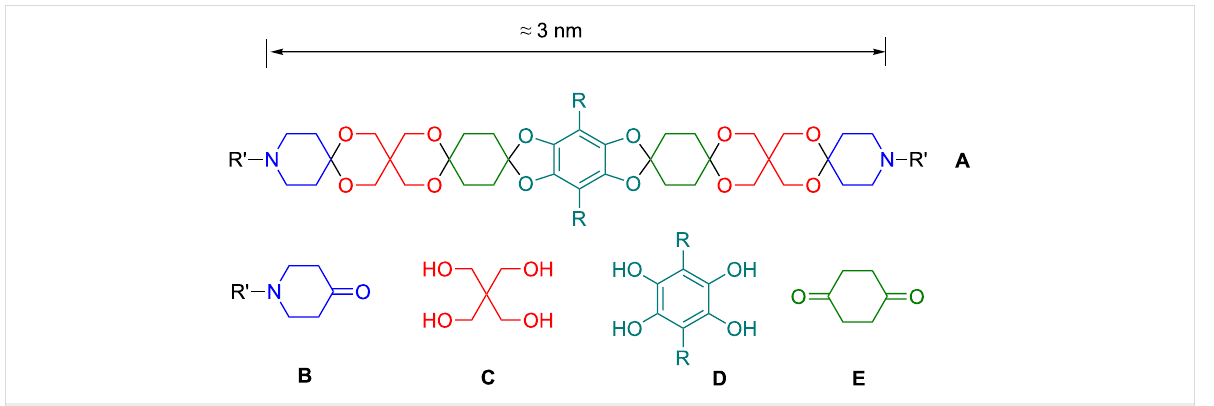
Figure 1: Typical OSK rod A with solubility enhancing sleeve ( D ) and building blocks B , C , E .